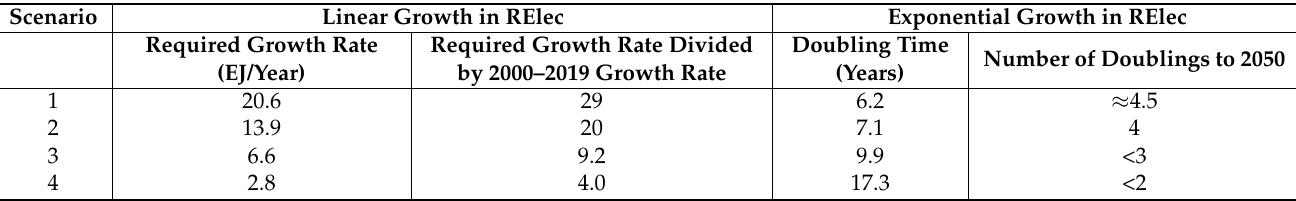
Table 2. Requirements for RElec to replace all TFEC by